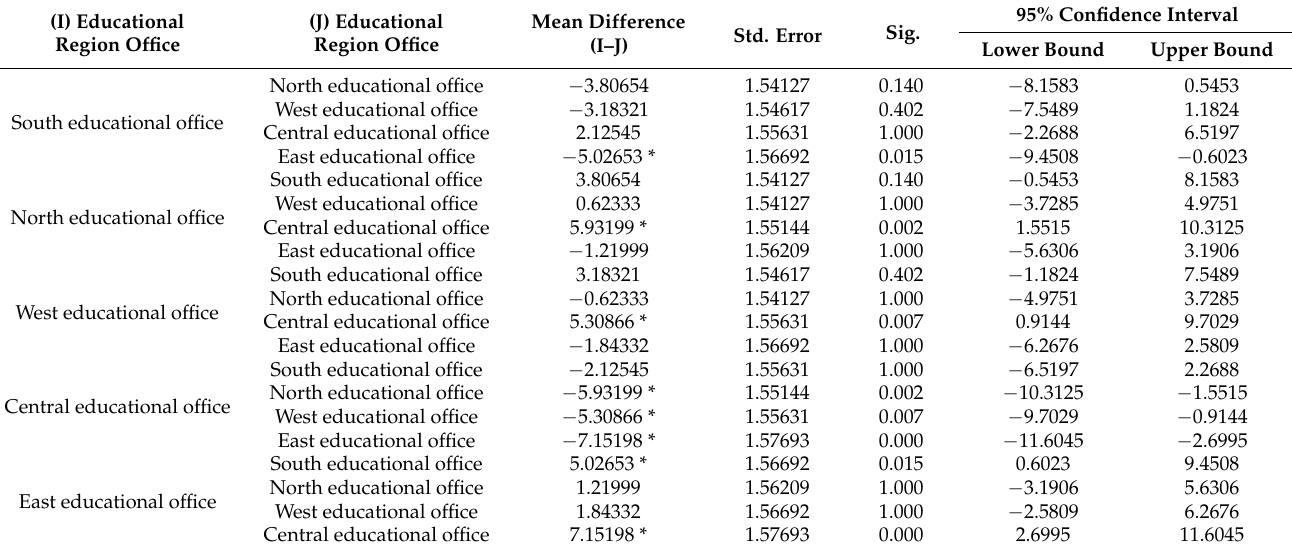
Table 6. Multiple mean comparisons between behavioural attention according to the educational region